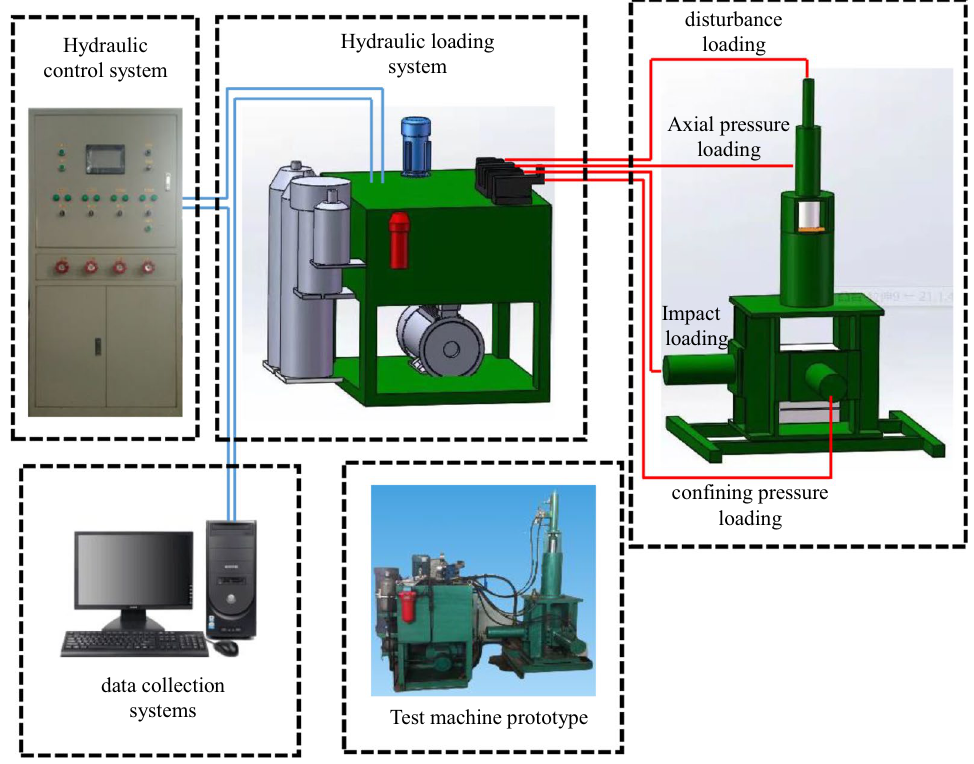
Fig. 4 Ultra-low friction test